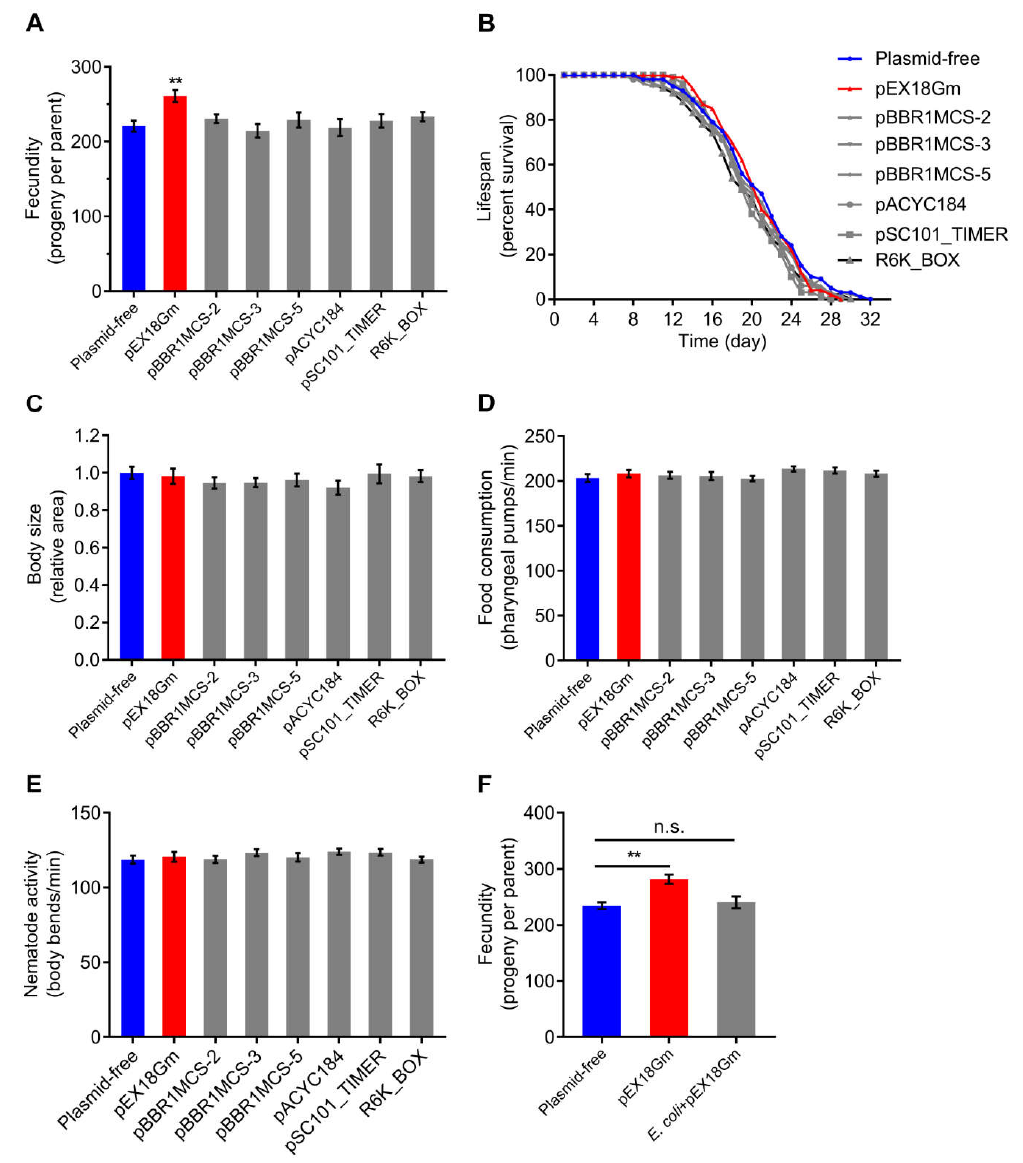
Figure 1. The response of C. elegans life-history traits to plasmids. Plasmid-free means E. coli OP50 does not harbor any plasmid. Different plasmids are indicated on the x axis. Plasmids were introduced into E. coli OP50 as a diet to feed C. elegans . ( A ) Fecundity of C. elegans on different diets. ( B ) Lifespan of adult animals fed different diets. ( C ) Relative body size of C. elegans on different diets. Animal body size was measured by ImageJ and was normalized to the body size of animals grown on the diet of plasmid-free E. coli OP50. ( D ) Food consumption of C. elegans on different diets. Food intake as measured by pharyngeal pumping rate. ( E ) Nematode activity of C. elegans on different diets. Animals’ activity as measured by body bending rate. ( F ) Fecundity of C. elegans directly fed on pEX18Gm plasmid. E. coli + pEX18Gm indicates the mixed diet that mixes E. coli OP50 with pEX18Gm plasmid in vitro (plasmid was extracted from an equal volume of E. coli OP50 harboring pEX18Gm). Error bars indicate ± standard error of the mean (SEM). ** p < 0.01 by Tukey’s multiple comparison test; n.s. indicates not